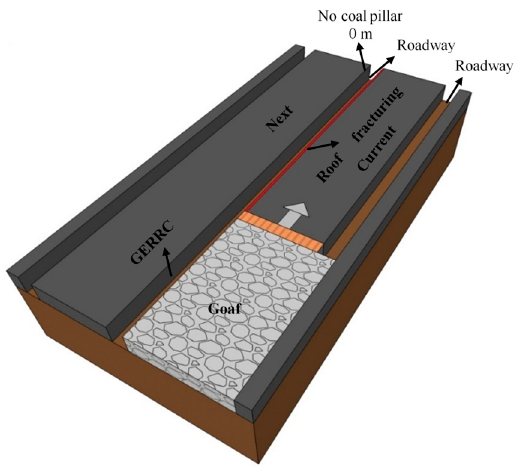
Figure 2. Schematic diagram of nonpillar mining with Gob-Side Entry Retaining by Roof Cutting.